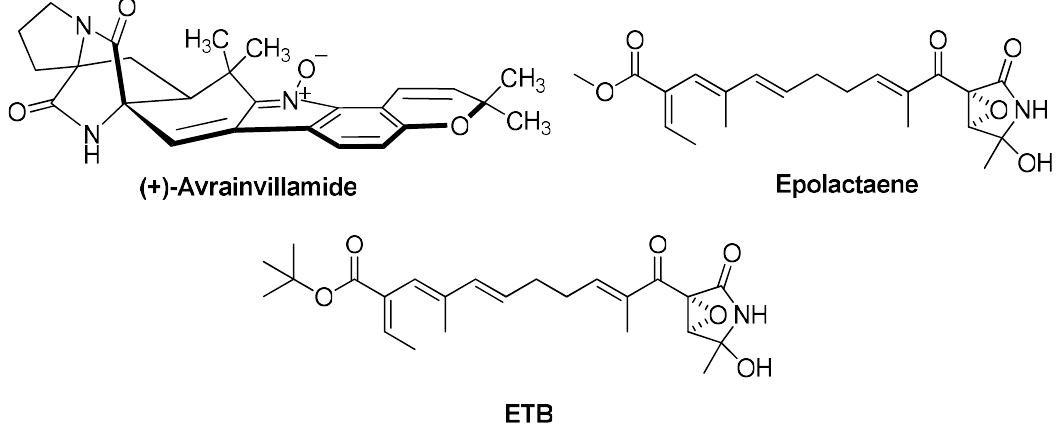
Figure 3. Chemical structures of Hsp60 inhibitors binding the Cys442 residues.